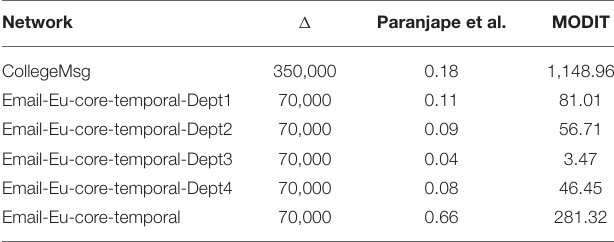
TABLE 5 | Comparison between MODIT and Paranjape’s algorithm.